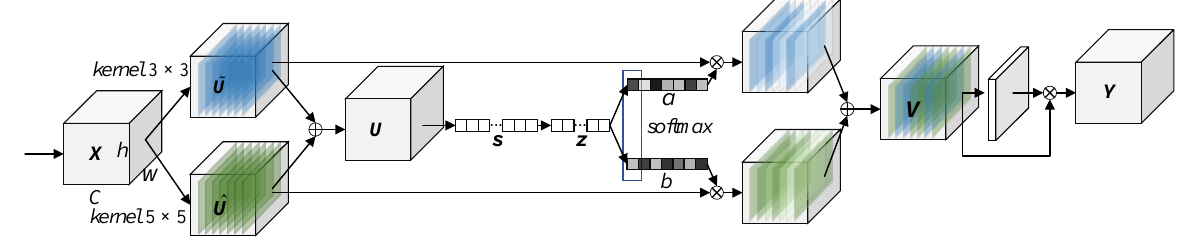
Figure 3. Structure diagram of hybrid attention.cp